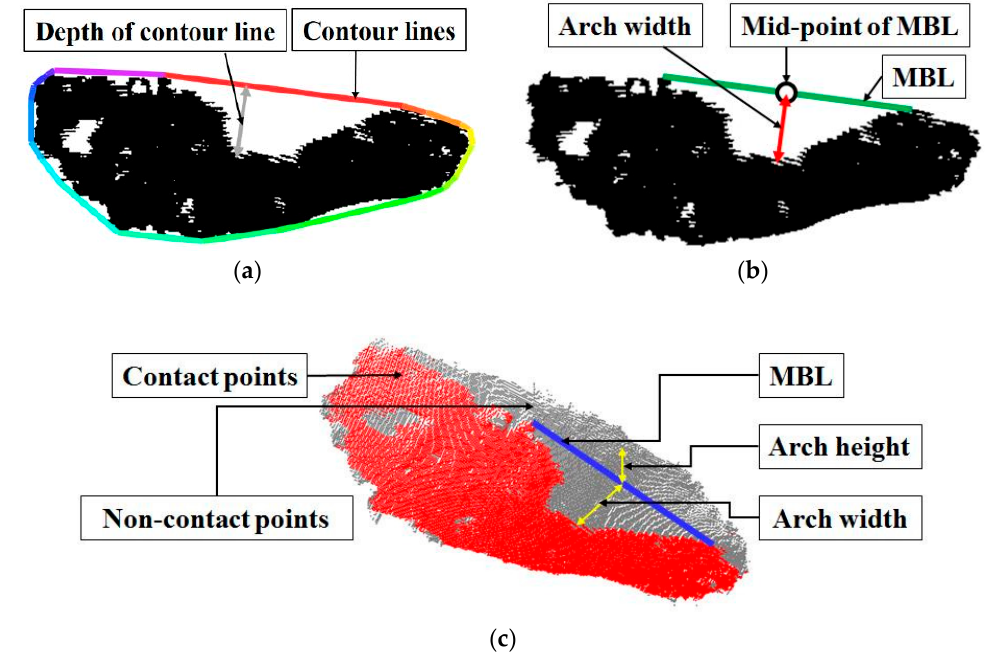
Figure 9. AW and AH computation: ( a ) result of convex hull detection algorithm applied to the contact region image, ( b ) the medial border line (MBL) and the mid-point of the MBL detection and AW computation, ( c ) 3D visualization of the AW and AH computation.